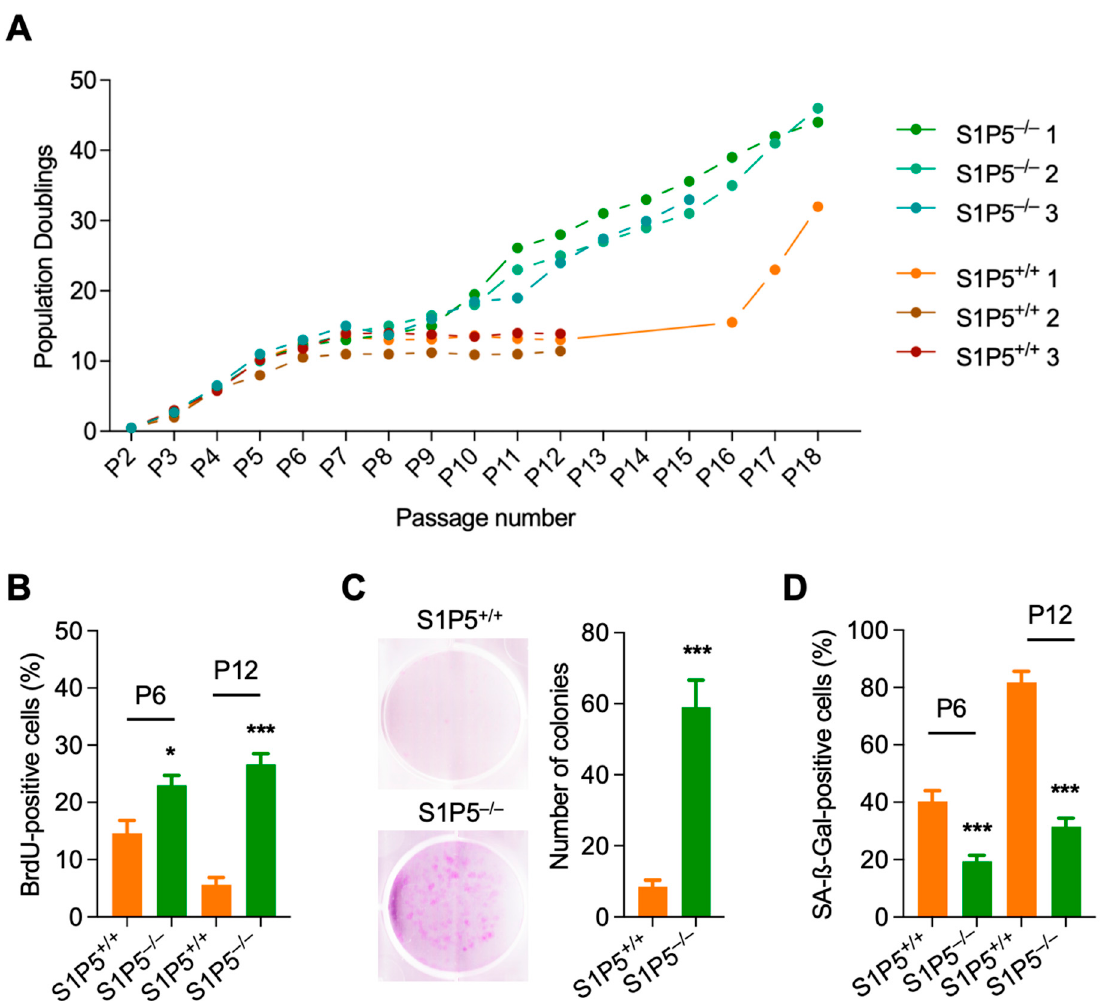
Figure 1. Primary S1P5 − / − MEFs are resistant to cellular senescence and prone to immortalization. ( A ), population doublings of S1P5 +/+ and S1P5 − / − primary MEFs over serial passaging according to 3T3 protocol. S1P5 +/+ and S1P5 − / − MEFs were each isolated from three different embryos. ( B ), wild-type and S1P5-deficient MEFs at passage six (P6) and passage 12 (P12), were labeled with BrdU for 3 h. The incorporated BrdU was visualized by immunofluorescence. DAPI staining was used to visualize nuclei. Data represent means ± SEM of three different clones performed in triplicates (*, p < 0.0114, ***, p < 0.0007). ( C ), colony formation capacity of S1P5 +/+ and S1P5 − / − MEFs at passage 6 (P6). Wild-type and S1P5-deficient MEFs were plated in a 6 well-plate and 10 days later cells were fixed and stained with crystal violet to visualize colony formation. Representative images are shown in the left panel. Right panel: means of colony number ± SEM of three different clones performed in triplicates (***, p < 0.0001). ( D ), S1P5 +/+ and S1P5 − / − MEFs at passage 6 (P6) and passage 12 (P12), were stained for SA- β -Gal activity. SA- β -Gal-positive cells were counted in more than five fields, and results represent the means ± SEM of three different clones performed in triplicates (***, p <